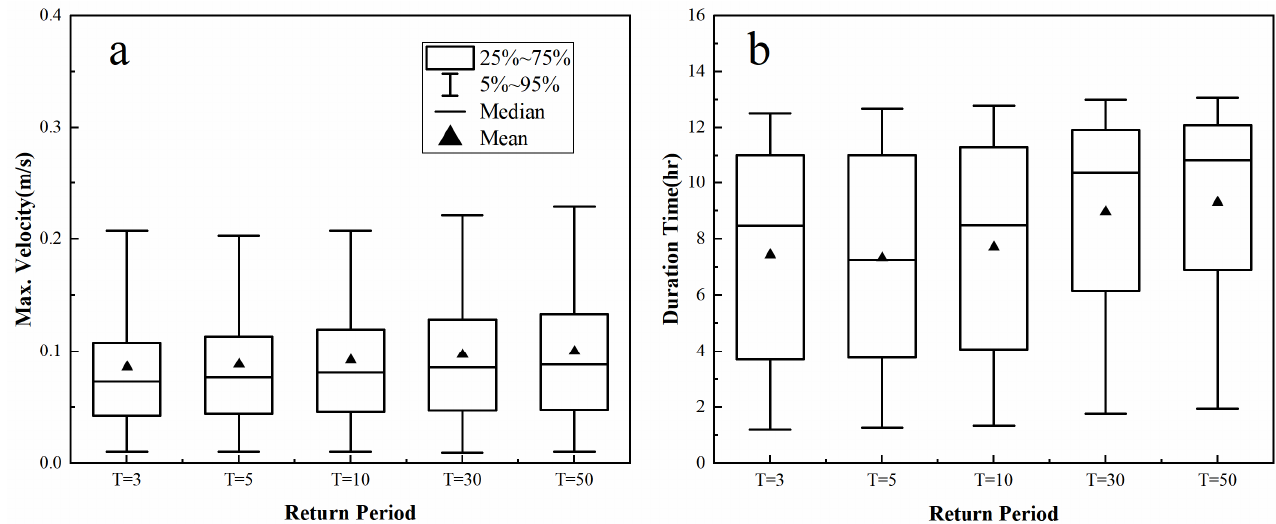
Figure 9. ( a ) Boxplots of the maximum velocities under different return periods; ( b ) boxplots of the duration time distribution of the inundation depths above 40 cm under different return periods.